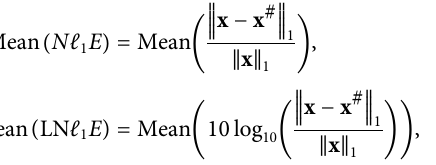
Frontiers in Applied Mathematics and Statistics |